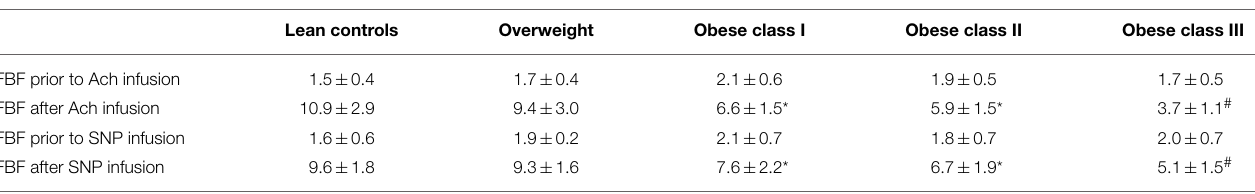
TABLE 2 | Forearm blood flow (FBF) at baseline and after all three doses of Ach or SNP. Lean controls